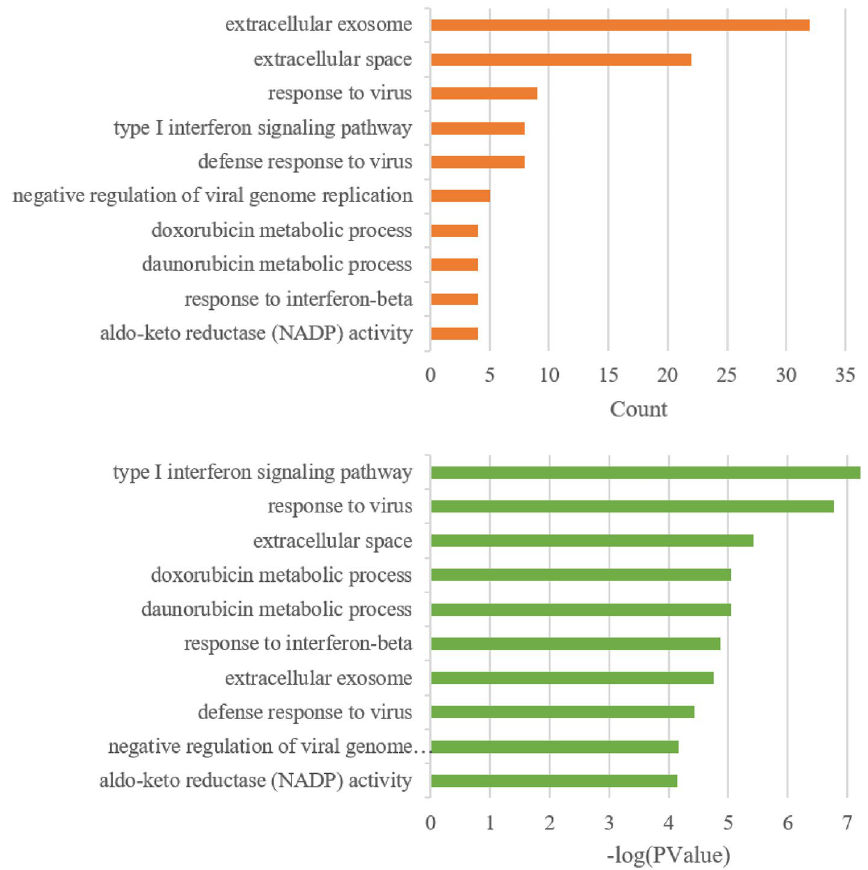
Figure 4. Top 10 Enriched gene ontologies (GO’s). The Y-axis stands for the GO biological process whereas the X-axis represents number of genes (upper) and significance